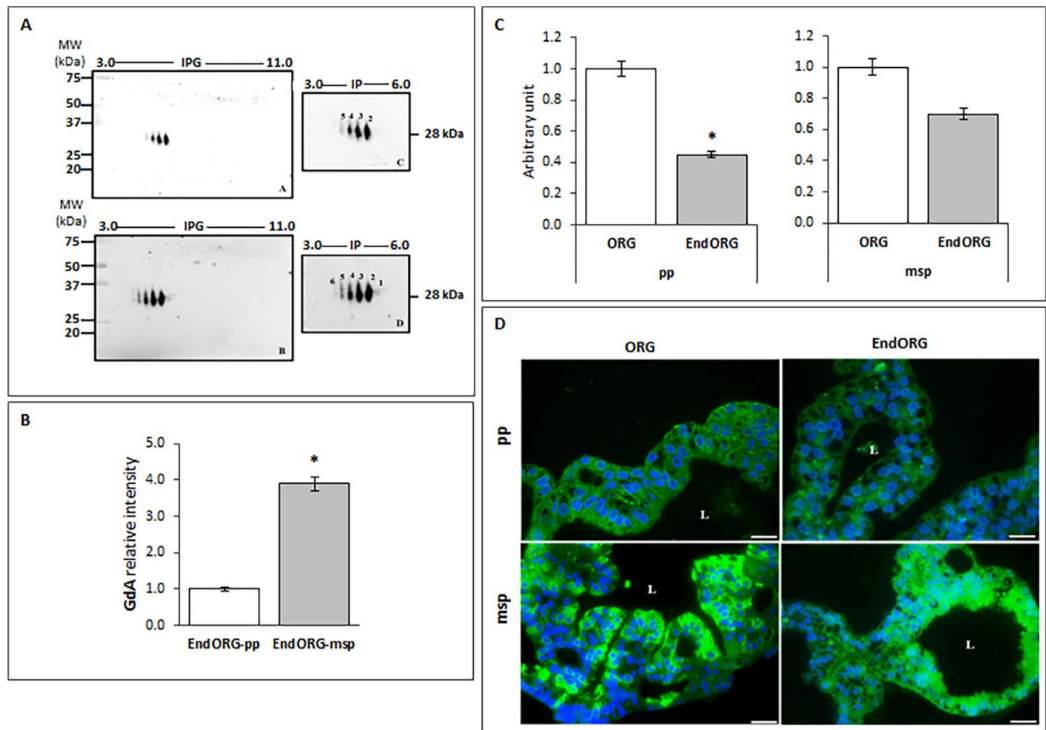
Figure 6. The EndORGGdA signature recapitulates disease traits. ( A ) Immunoblotting detection of GdA after 2-dimensional (2-D) electrophoresis in EndORG-pp (upper panel) that revealed 5 main glycoforms, with spot number 1 scarcely visible. Immunoblotting detection of GdA in EndORG-msp (bottom panel) showed that four glycoforms are prominent, while the spots 1 and 6 are barely identifiable. ( B ) The computer-assisted semiquantitative analysis of the overall relative intensity of the GdA reactive spots (pixel / mm 2 ), normalized with respect to β -Actin, demonstrated a significant decrease in EndORG-pp, mimicking the proliferative phase. The experiment was repeated twice, independently, with similar results. ( C ) Computer-assisted semiquantitative analysis of the overall relative intensity of the GdA reactive spots in ORG and EndORG mimicking the proliferative (pp) and the mid secretory (msp) phases of the endometrial cycle. By comparing the GdA quantitative expression between ORG and EndORG, we highlight a significant decrease at the proliferative phase in EndORG. * p < 0.05. Values are expressed as mean ± SD. The experiment was repeated twice, independently, with similar results. ( D ) Representative microphotographs of GdA immunofluorescence staining in ORG and EndORG treated to mimic the proliferative (pp) and the mid secretory (msp) phase of the menstrual cycle. GdA, green; 4 (cid:48) ,6-diamidino-2-phenylindole (DAPI), blue. The images are representative of n = 3 independent experiments, which gave similar results. Scale bar, 50 µ m. L: